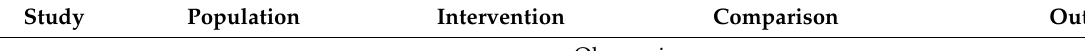
Table 1. Summary of the results of the included